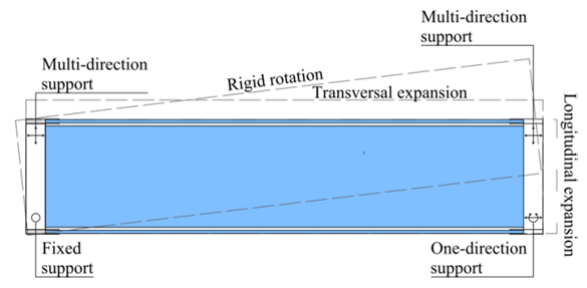
Fig. 3 Bottom view of the floor slab: global support condition.